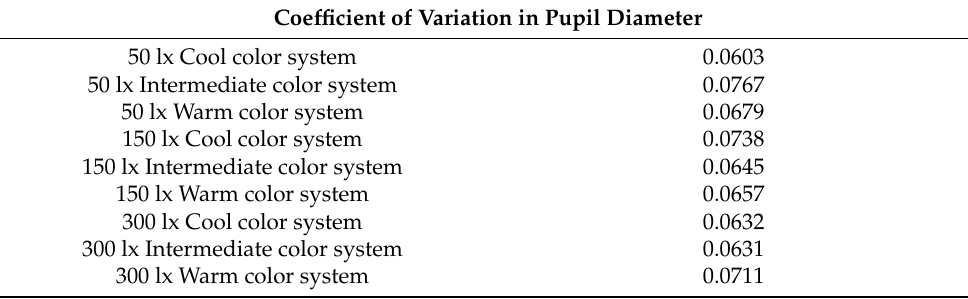
Table 9. Pupil diameter variation